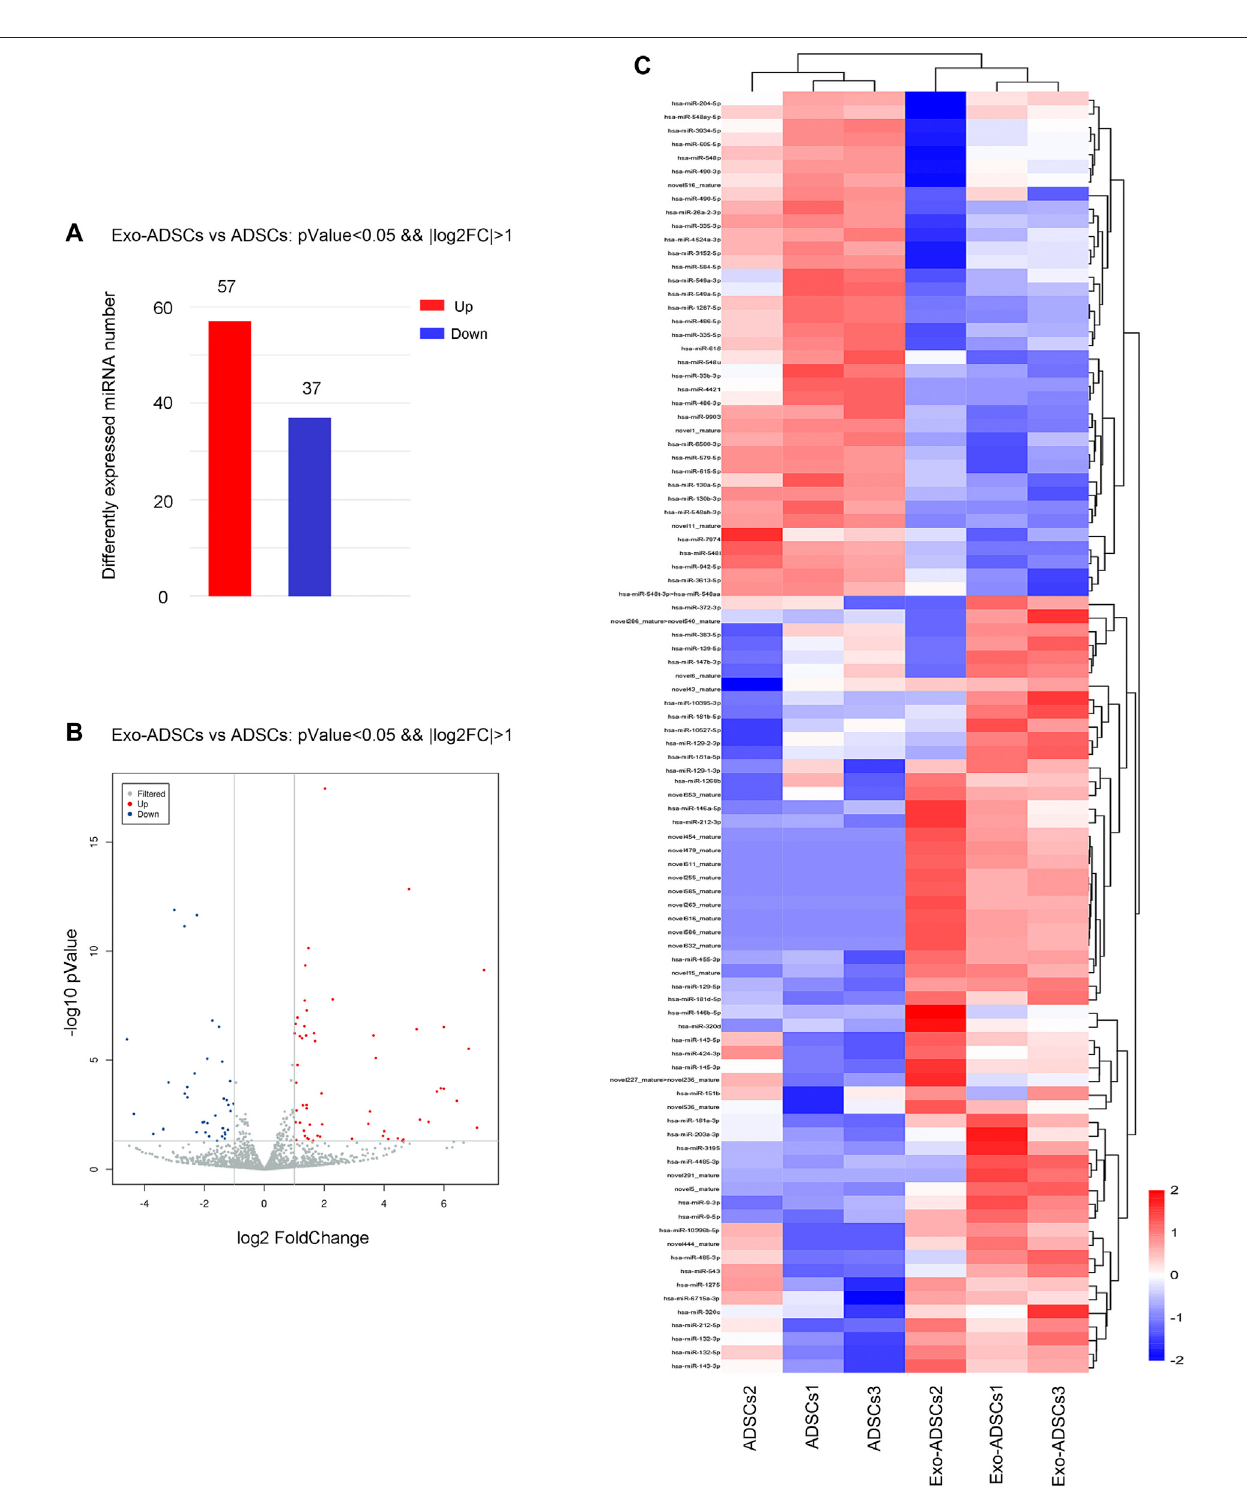
FIGURE4 | ThemiRNAexpression pro fi le ofExo-ADSCs. (A) The number ofaberrantly expressed miRNAs with up- or downregulation. (B) Volcano map showing the distribution of differentially expressed miRNAs. Red dots, signi fi cantly upregulated genes. Blue dots, signi fi cantly downregulated genes. Gray dots, nondifferentially expressed genes. (C) Heat map showing the dominant cluster pattern of miRNAs. Red signals and blue signals represent upregulated and downregulated expression, respectively.